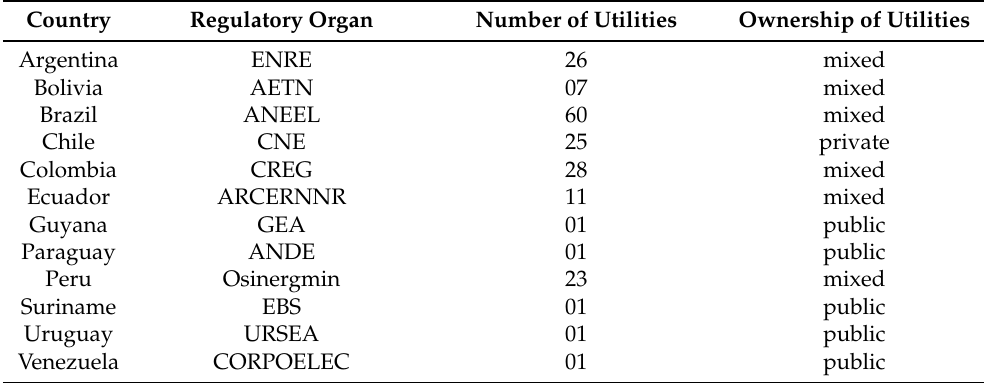
Table 1. Review of regulatory organs and distributors in South America. Country Regulatory Organ Number of